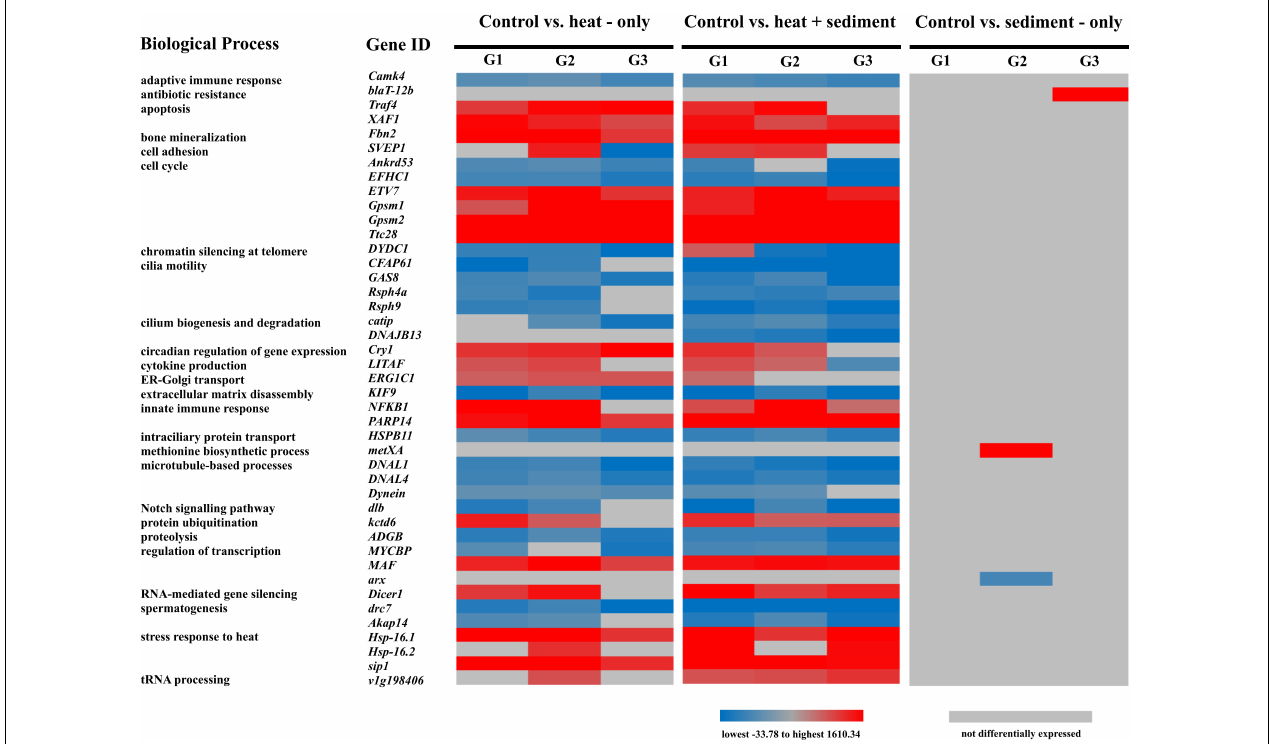
FIGURE 4 | Heat map showing functional categories based on UniProtKB, gene IDs and expression patterns [lowest fold change (FC) in blue to highest FC in red] of differentially expressed genes (DEGs) across genotypes – G1, G2, and G3; and across treatment comparisons: “C” vs. “H” and “C” vs. “H+S.” While there was no DEG found for the comparison: control vs. sediment-only which is common across three genotypes, genes specific to this treatment and genotypes are included here for comparative